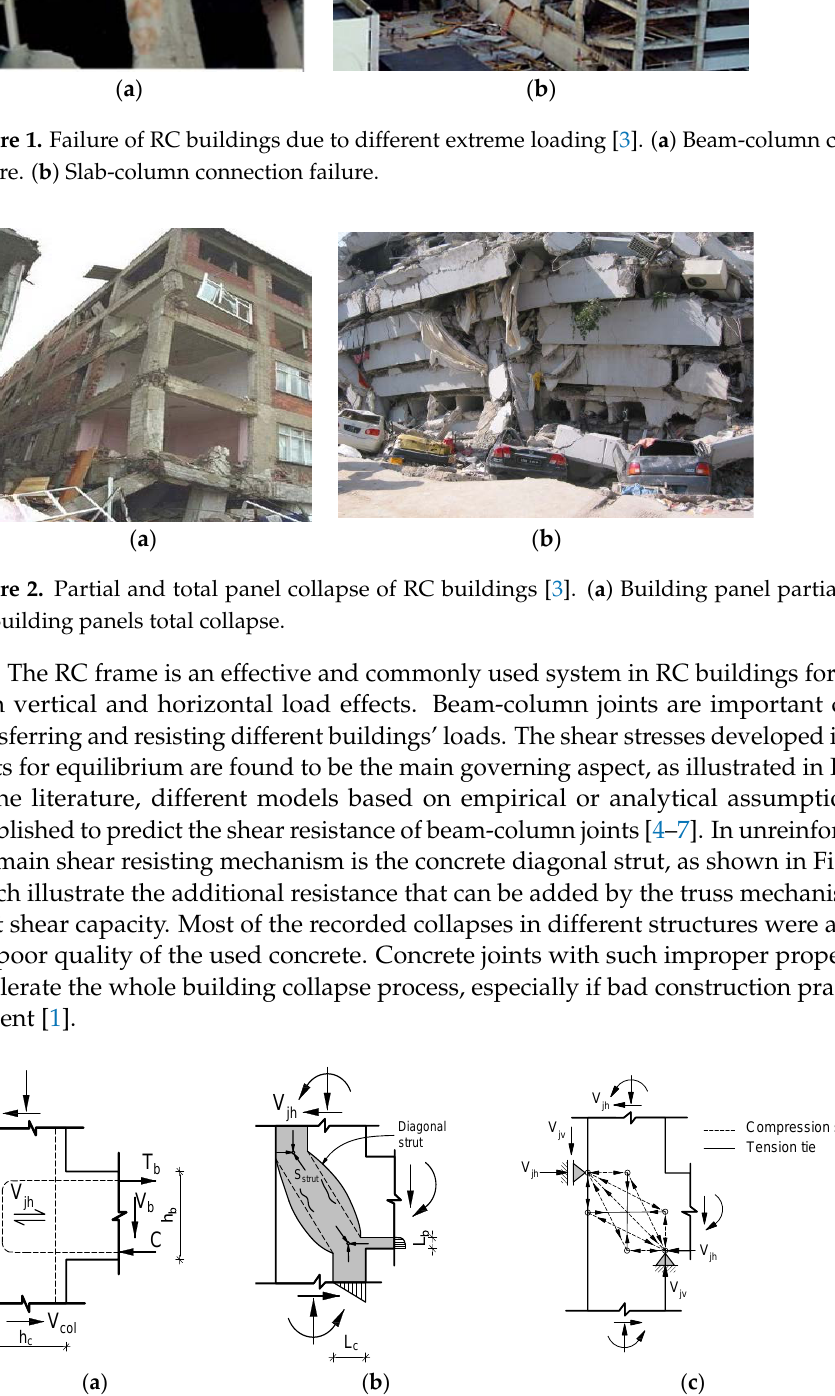
Figure 3. Exterior joint shear stress and different resisting mechanisms. ( a ) Joint boundary actions. ( b ) Concrete diagonal strut. ( c ) Reinforced joint equilibrium. In which, V jh , V col , and V b are the shear forces in the joint, column, and beam respectively.